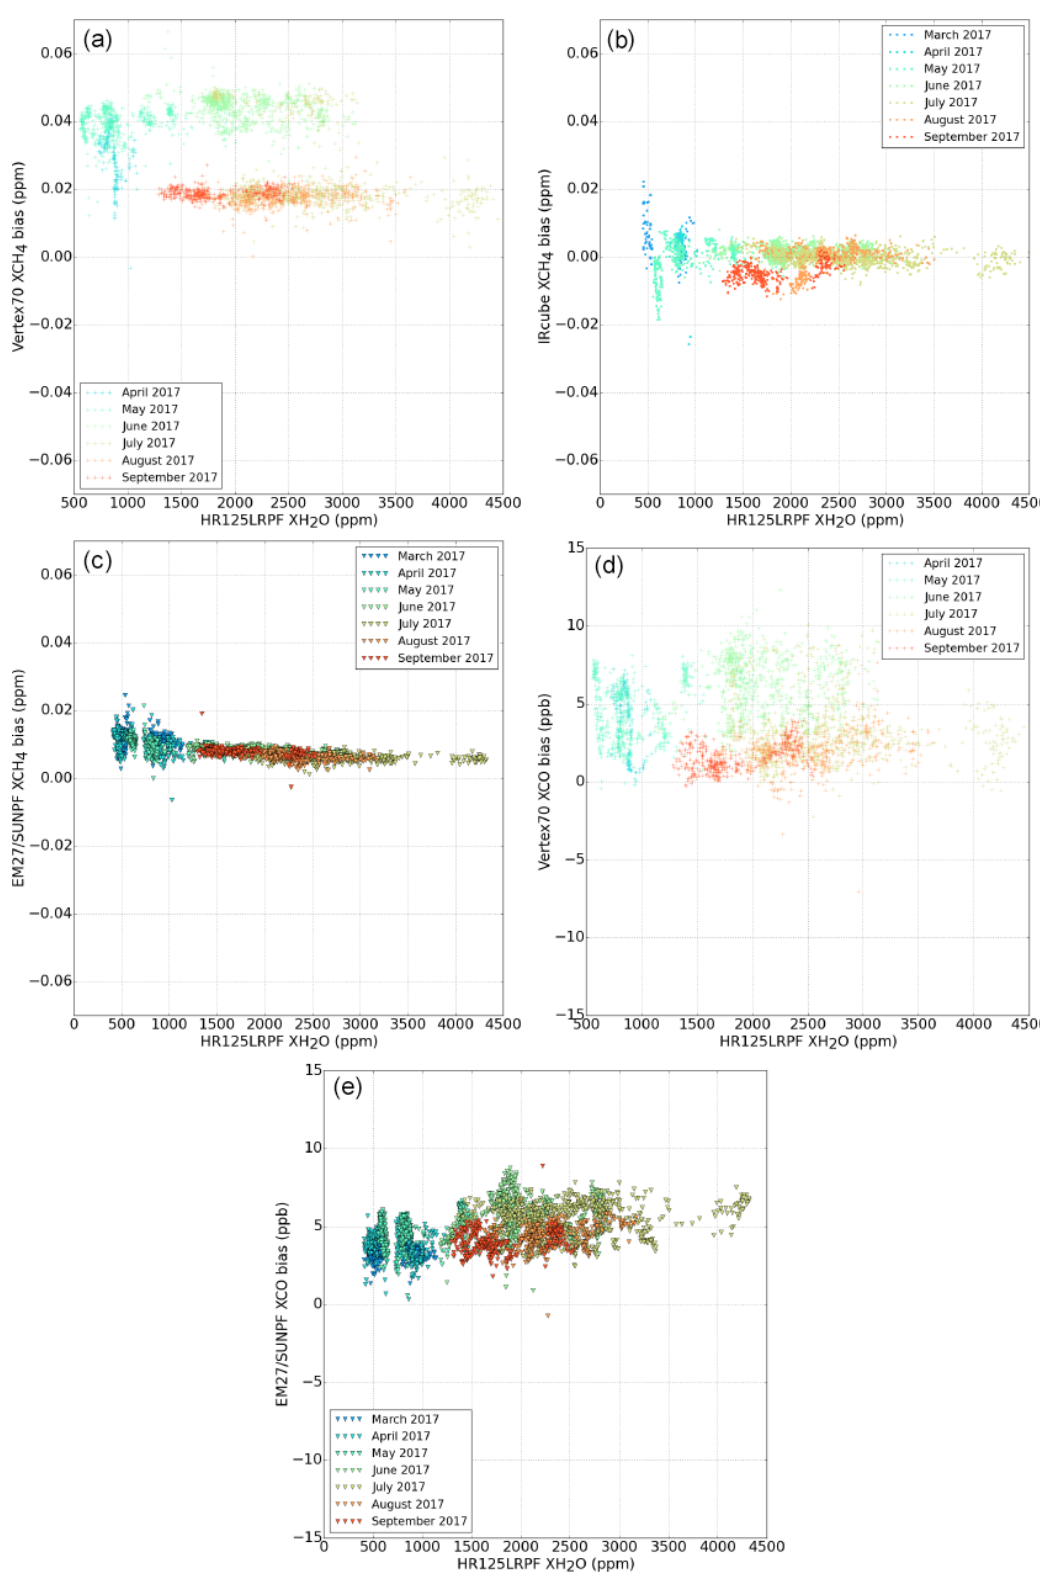
Figure F2. XCH 4 bias relative to HR125LR for Vertex70 (a) , IRcube (b) , and EM27/SUN (c) . XCO bias relative to HR125LR for Ver- tex70 (d) and EM27/SUN (e) plotted with respect to the total column water vapour retrieved by the reference HR125LR measurements. The colours represent the measurement performed during the different months of the